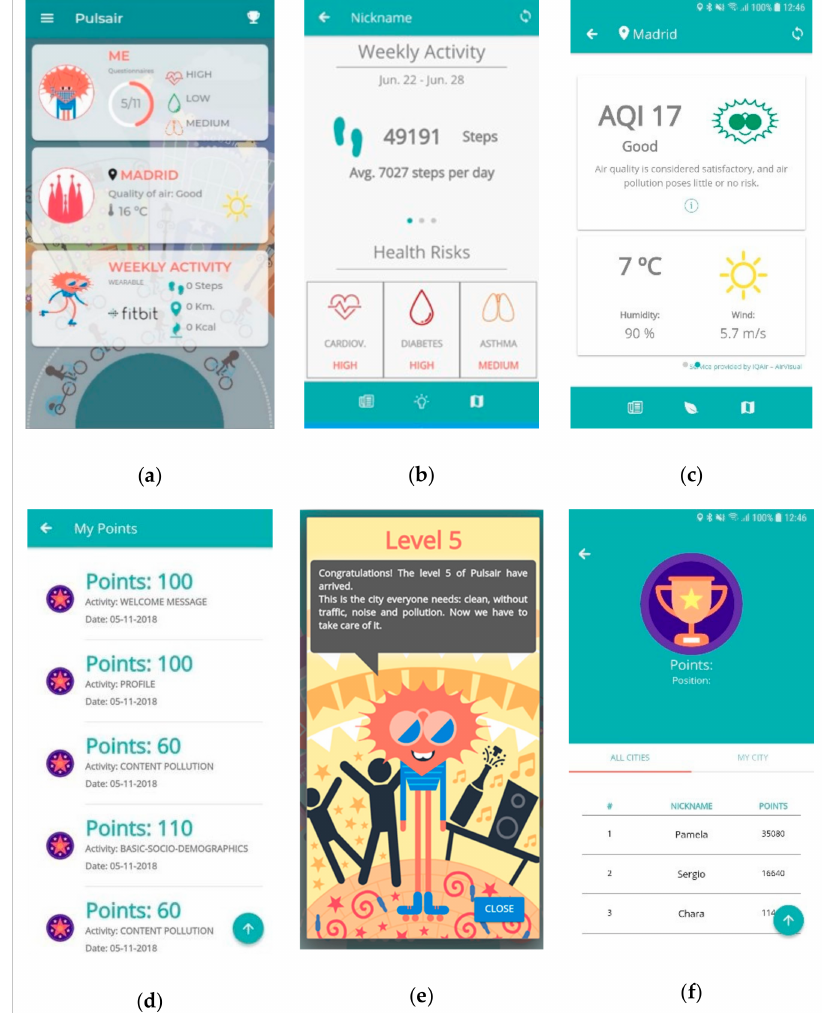
Figure 3. PulsAir mobile application interface screenshots: ( a ) Home Menu; ( b ) “Me” module; ( c )